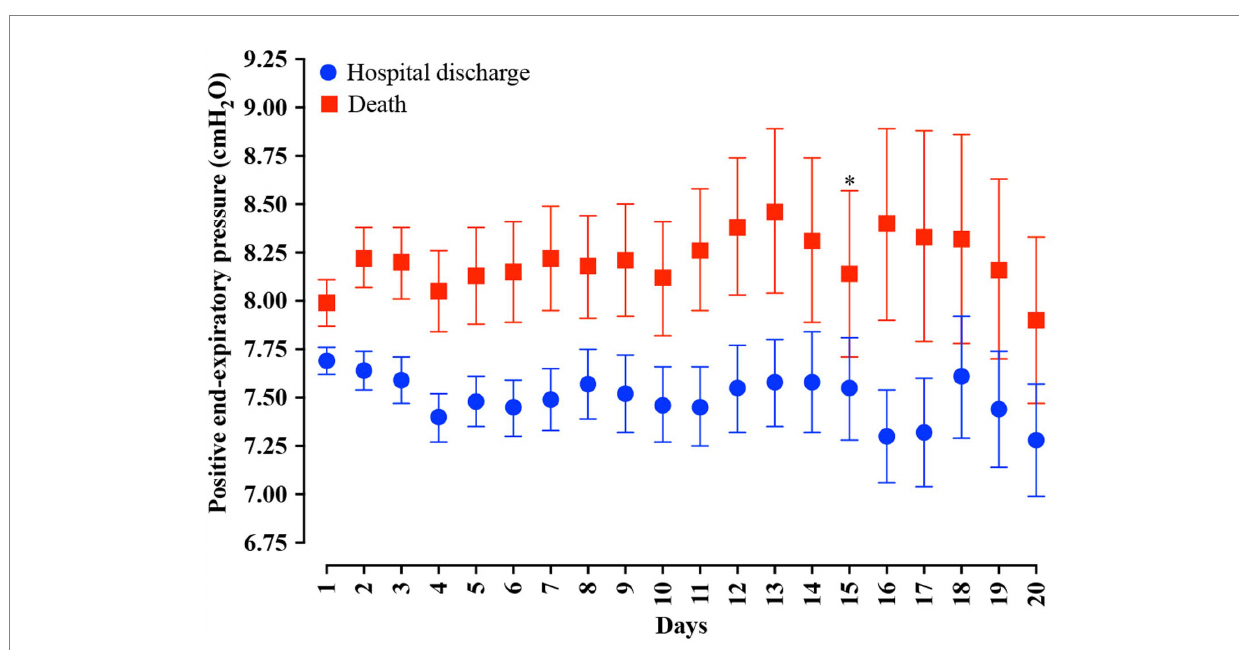
FIGURE 4 Distribution of the positive end-expiratory pressure (PEEP) values according to the days of invasive mechanical ventilation. Blue represents the individuals that were discharged. Red represents the individuals that died. We carried out the statistical analysis using the Mann–Whitney test and a 0.05 alpha error. The data is presented as mean [95% confidence interval, 95%CI]. * p >